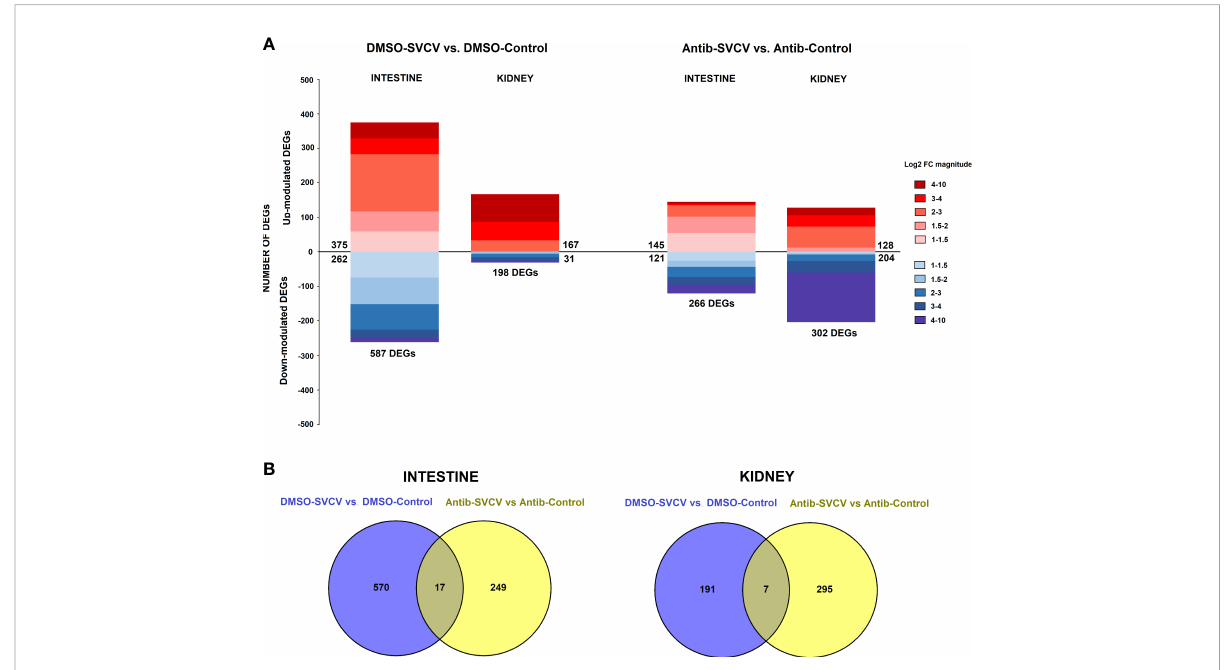
FIGURE 5 Comparative transcriptome analyses of zebra fi sh exposed to antibiotics or vehicle (DMSO) and infected with SVCV. (A) Stacked column charts re fl ecting the number and intensity (in log2 FC value) of the DEGs in the intestine and kidney at 24 hpi with SVCV. (B) Venn diagrams showing the number of common and exclusive DEGs after SVCV infection in DMSO- and SMX+CLA-treated fi